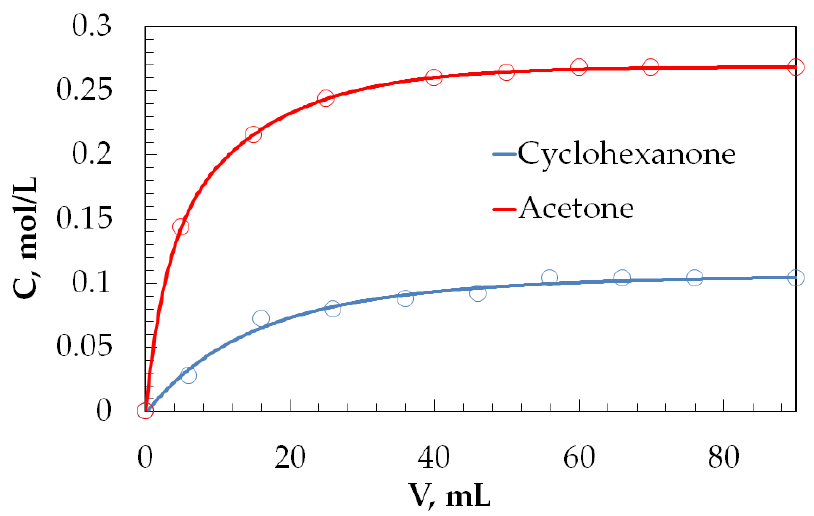
Figure 14. Curves of the acetone and cyclohexanone sorption under dynamic conditions.